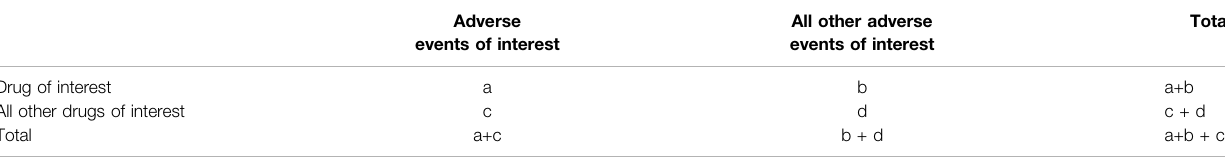
TABLE 1 | Two-by-two contingency table for disproportionality analyses.